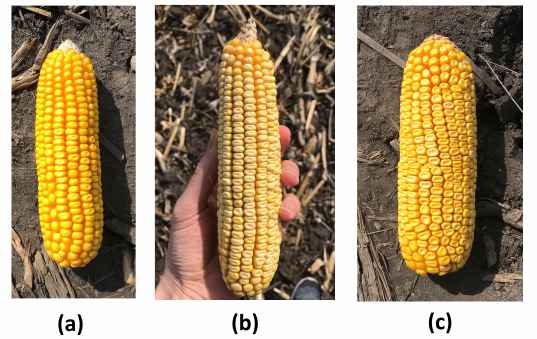
Figure 1. Three genetically different corn ears. Images ( a – c ) have different backgrounds. We included different types of backgrounds such as soil, grass, and hands in the training data to make the proposed method robust against the image